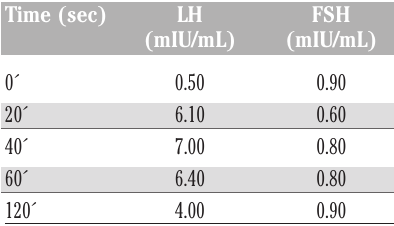
Table 2. Poor response of FSH during LH- RH